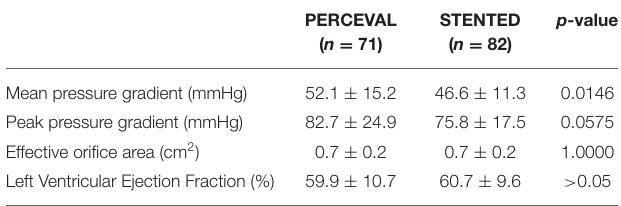
TABLE 2 | Preoperative echocardiographic